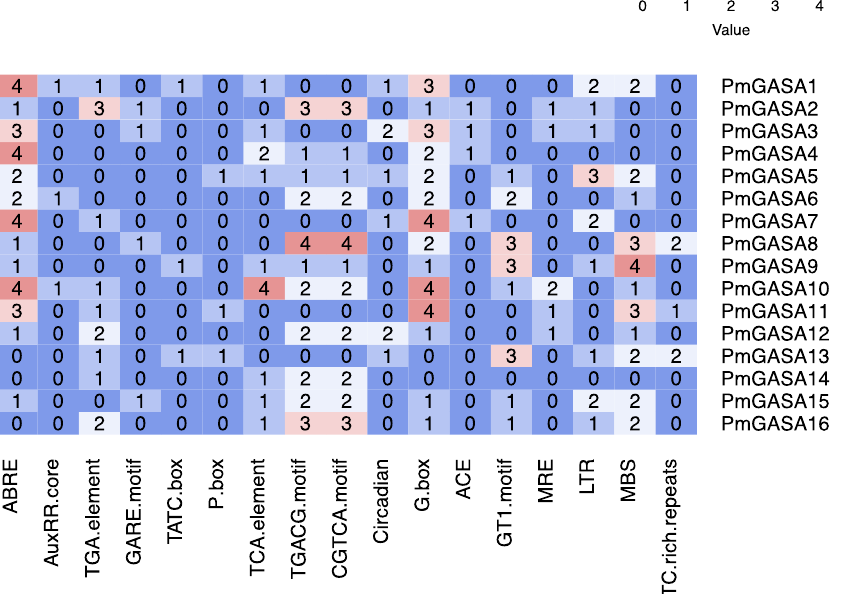
Figure 5. Analysis of cis-regulatory elements within PmGASA gene promoters. The numerical values and colors represent the number of cis-elements identified within each PmGASA gene.